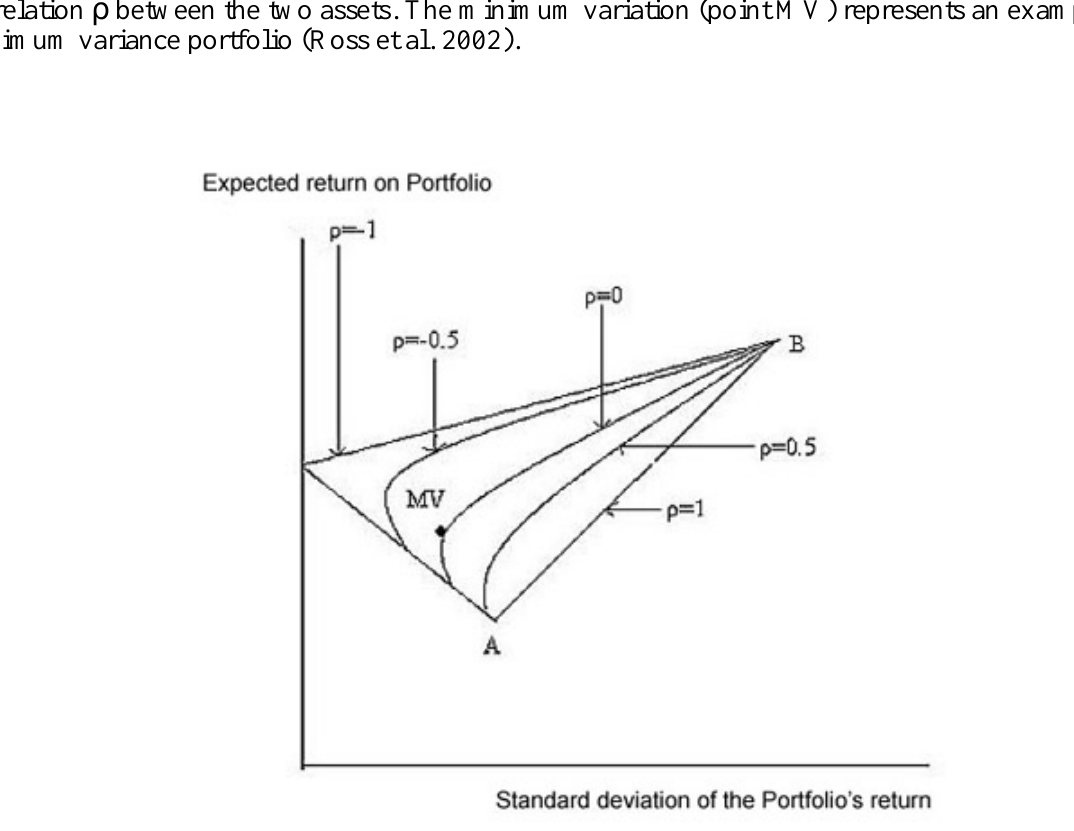
Fig. 1. The curved lines are "efficient frontiers" showing the most optimal risk-return values for different two assets portfolios against the variation in return. Each curve represents a different correlation r between the two assets. The minimum variation (point MV) represents an example of a minimum variance portfolio (Ross et al.